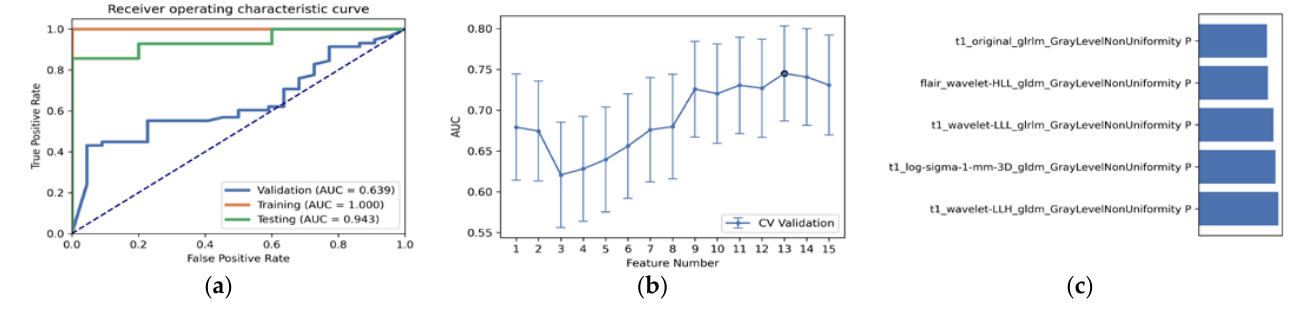
Figure 5. The best diagnostic performance of the three combined multi-sequence was the T1+T2+T1Gd combined multi-sequence with the following settings: wavelet image filter, Z-score data normalization, PCA dimension reduction, RFE feature selection, and RF classifier. ( a ) Receiver operating characteristic (ROC) curves of the training, testing, and validation sets; ( b ) FAE software’s suggestion of a candidate 11-feature model according to the “one-standard error” rule; ( c ) the 11 radiomic features with the highest average feature importance calculated by the best settings with the T1+T2+T1Gd combined multi-sequence.